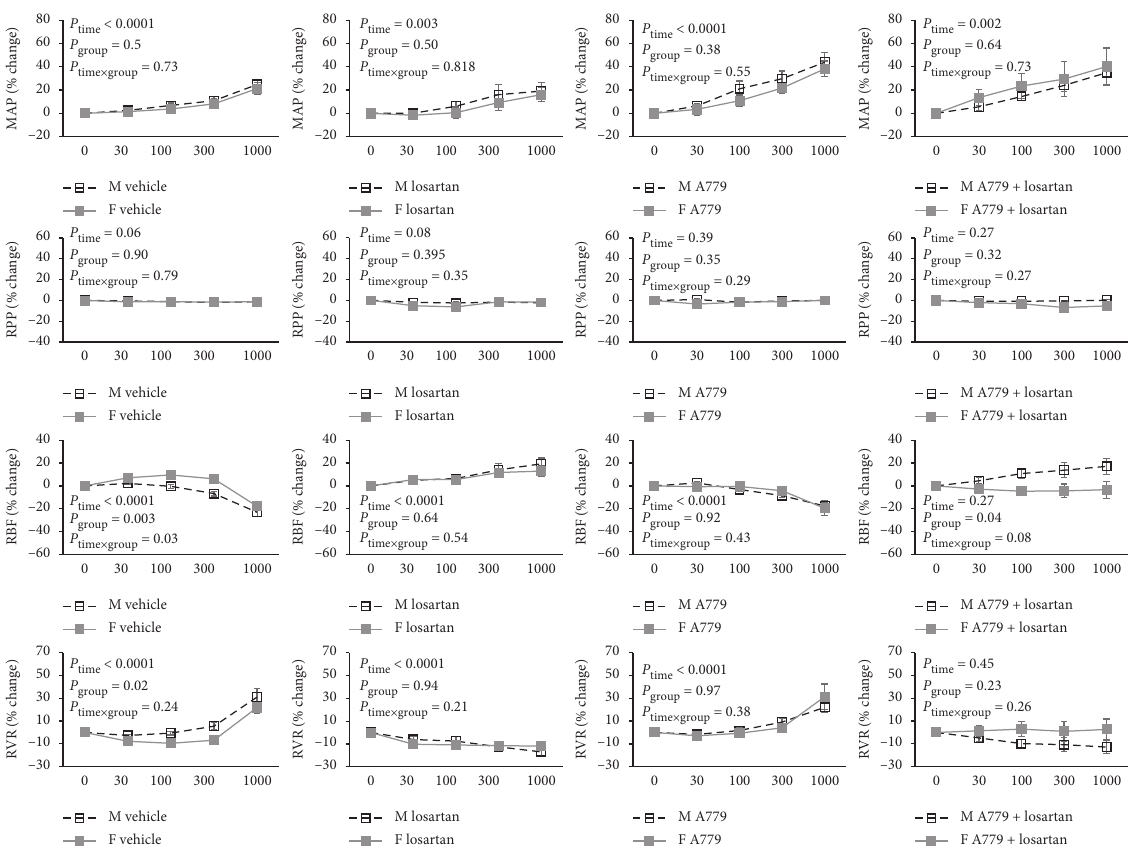
Figure 4: The effect of graded Ang II infusion on hemodynamics parameters. MAP, RPP, RBF, and RVR stand for mean arterial pressure, renal perfusion pressure, renal blood flow, and renal vascular resistance in male M and female F rats. Data are presented as mean ± SEM and were analyzed using repeated-measures ANOVA with the factors group (sex), time (dose of Ang II), and their